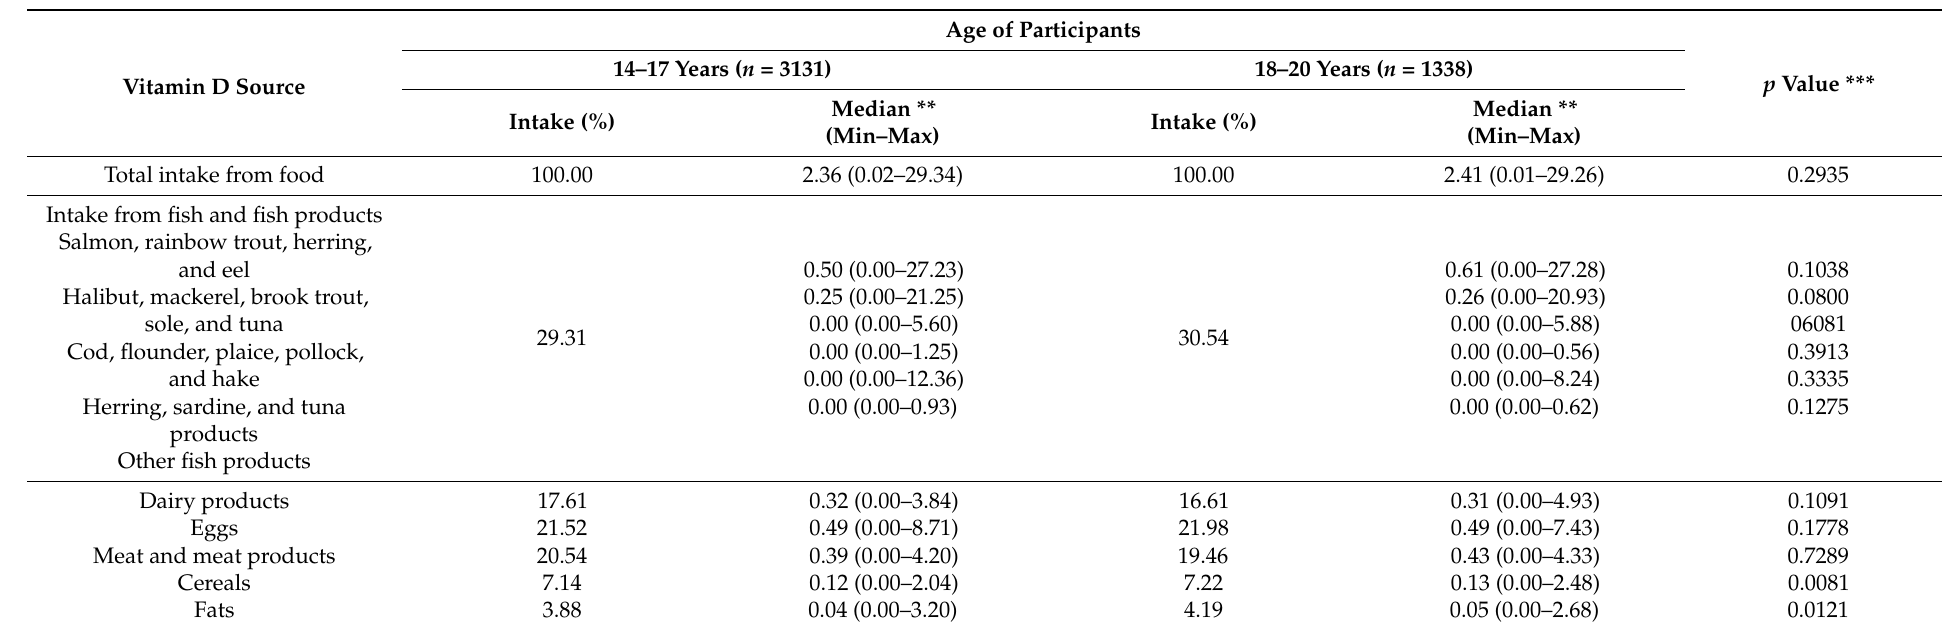
Table 5. Comparison of dietary vitamin D intake from various food groups ( µ g per day) in the age subgroups of female post-primary school